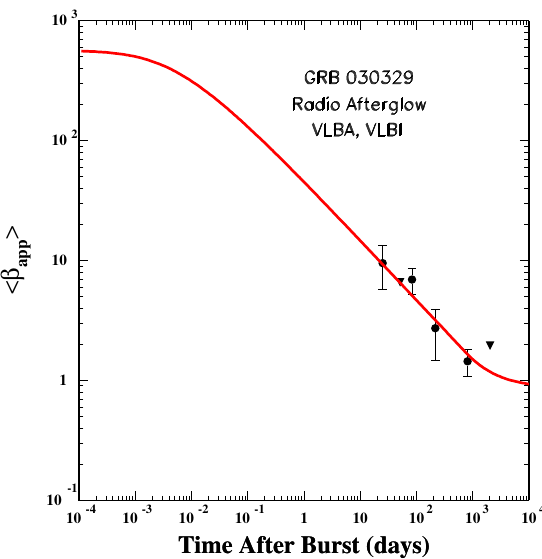
Figure 26. The time-averaged expansion rate of the radio image of GRB030329/SN2003dh [172]. The line is the predicted (cid:104) β app (cid:105) of the CB, which produced GRB030329 and its AG, assuming that 2 R ⊥ is its distance from